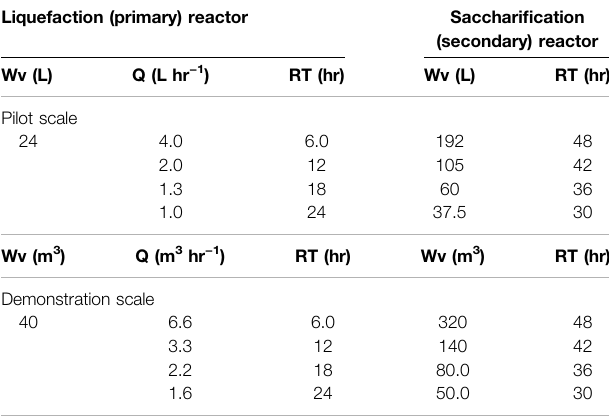
TABLE1| Processdesignoftwo-stagesystems(total τ of54 h)forthecontinuous enzymatic hydrolysis of MSW-derived pulp: pilot and demonstration scales. Liquefaction (primary) reactor Sacchari fi cation (secondary)